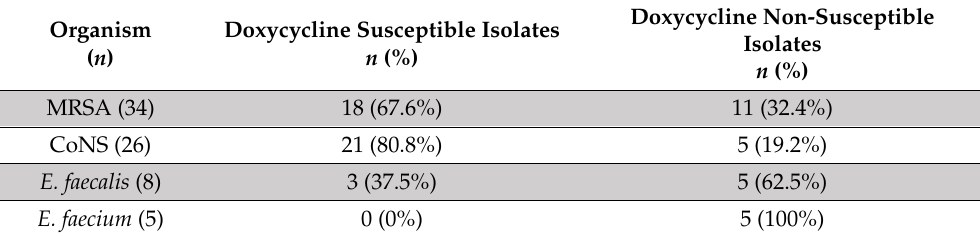
Table 1. PJI clinical isolates that were doxycycline non-susceptible for the four different Gram-positive bacterial groups evaluated.